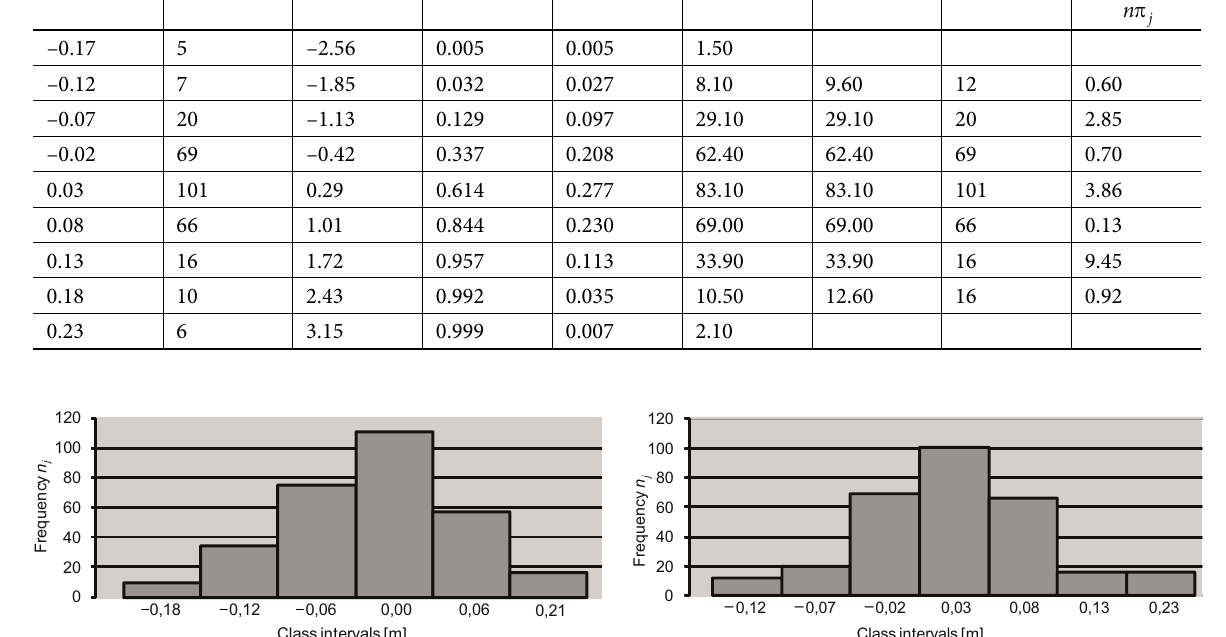
Fig. 2. Frequency distribution histogram for the Y-axis coordinate deviations (Přívoz cad.